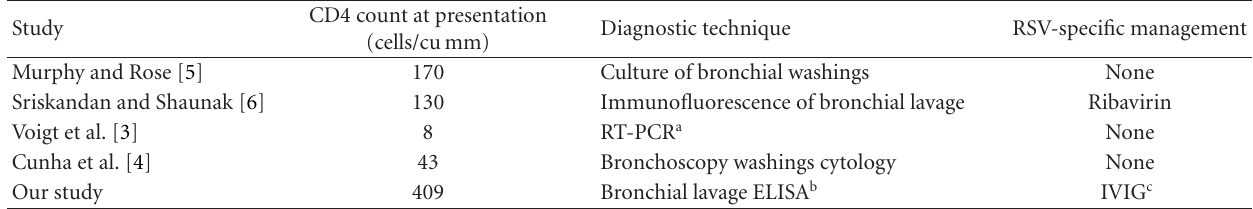
Table 1: Previous case reports of RSV in HIV-positive